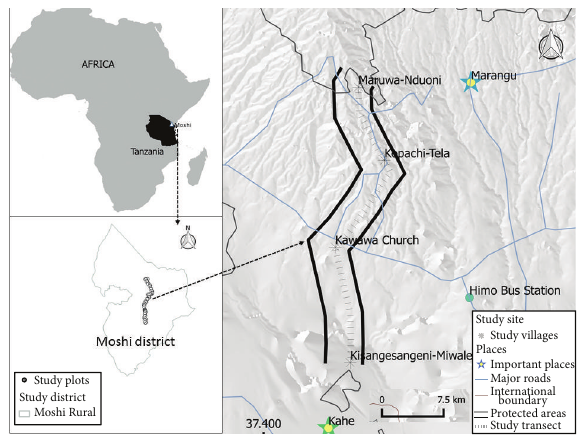
Figure 1: Location of the study site on the southern slopes of Mount Kilimanjaro, Tanzania. Insert map indicates the location of Tanzania within Africa continent